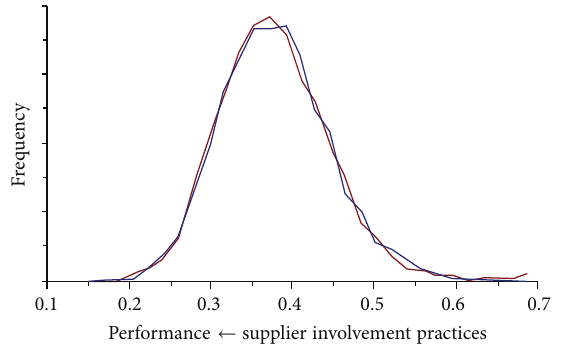
Figure 3: The posterior distribution of the first and last thirds of the drawn analysis samples of supplier involvement practices → NPD project performance. Note: Blue depicts post-convergence posterior distribution and red pre-convergence posterior distribution.